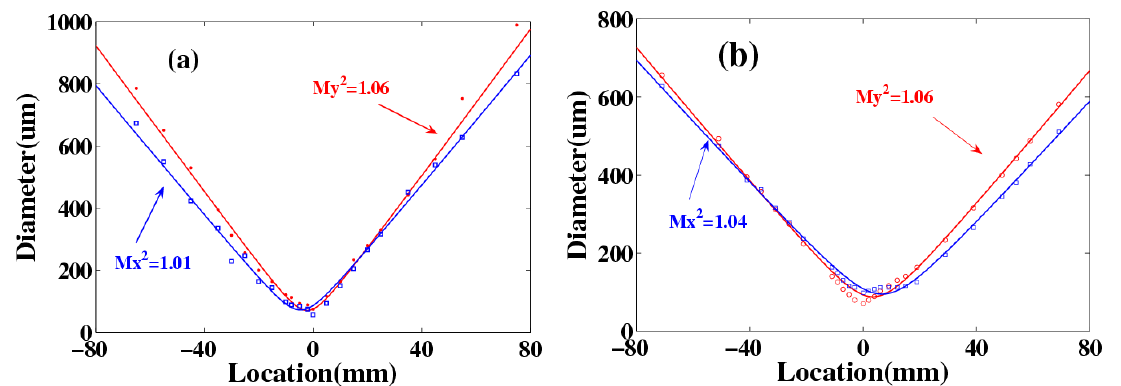
Figure 17. Measured beam diameters and M 2 in both X and Y directions for (a) AS1 and (b) AS2 sideband, respectively